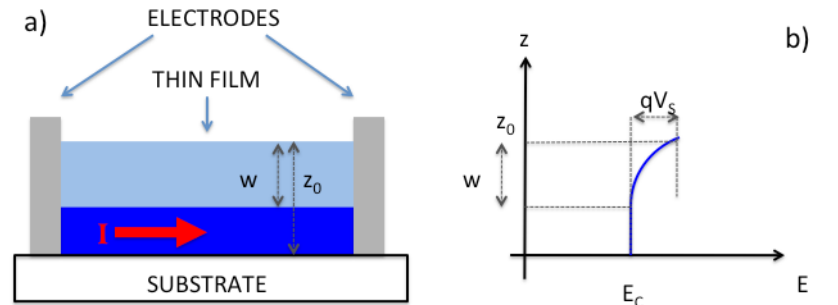
Figure 1. Schematic representation of the structure ( a ) and working principle ( b ) of thin film gas